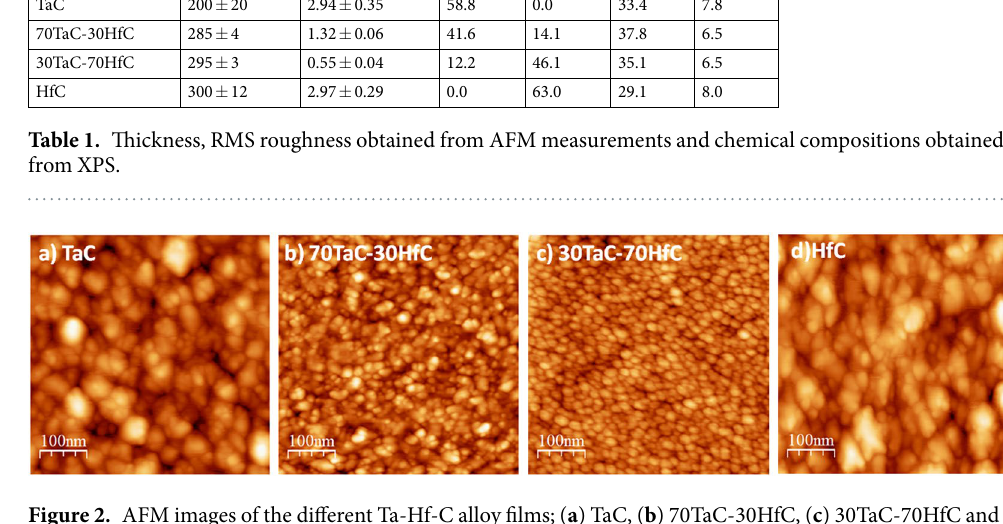
Figure 2. AFM images of the different Ta-Hf-C alloy films; ( a ) TaC, ( b ) 70TaC-30HfC, ( c ) 30TaC-70HfC and ( d )